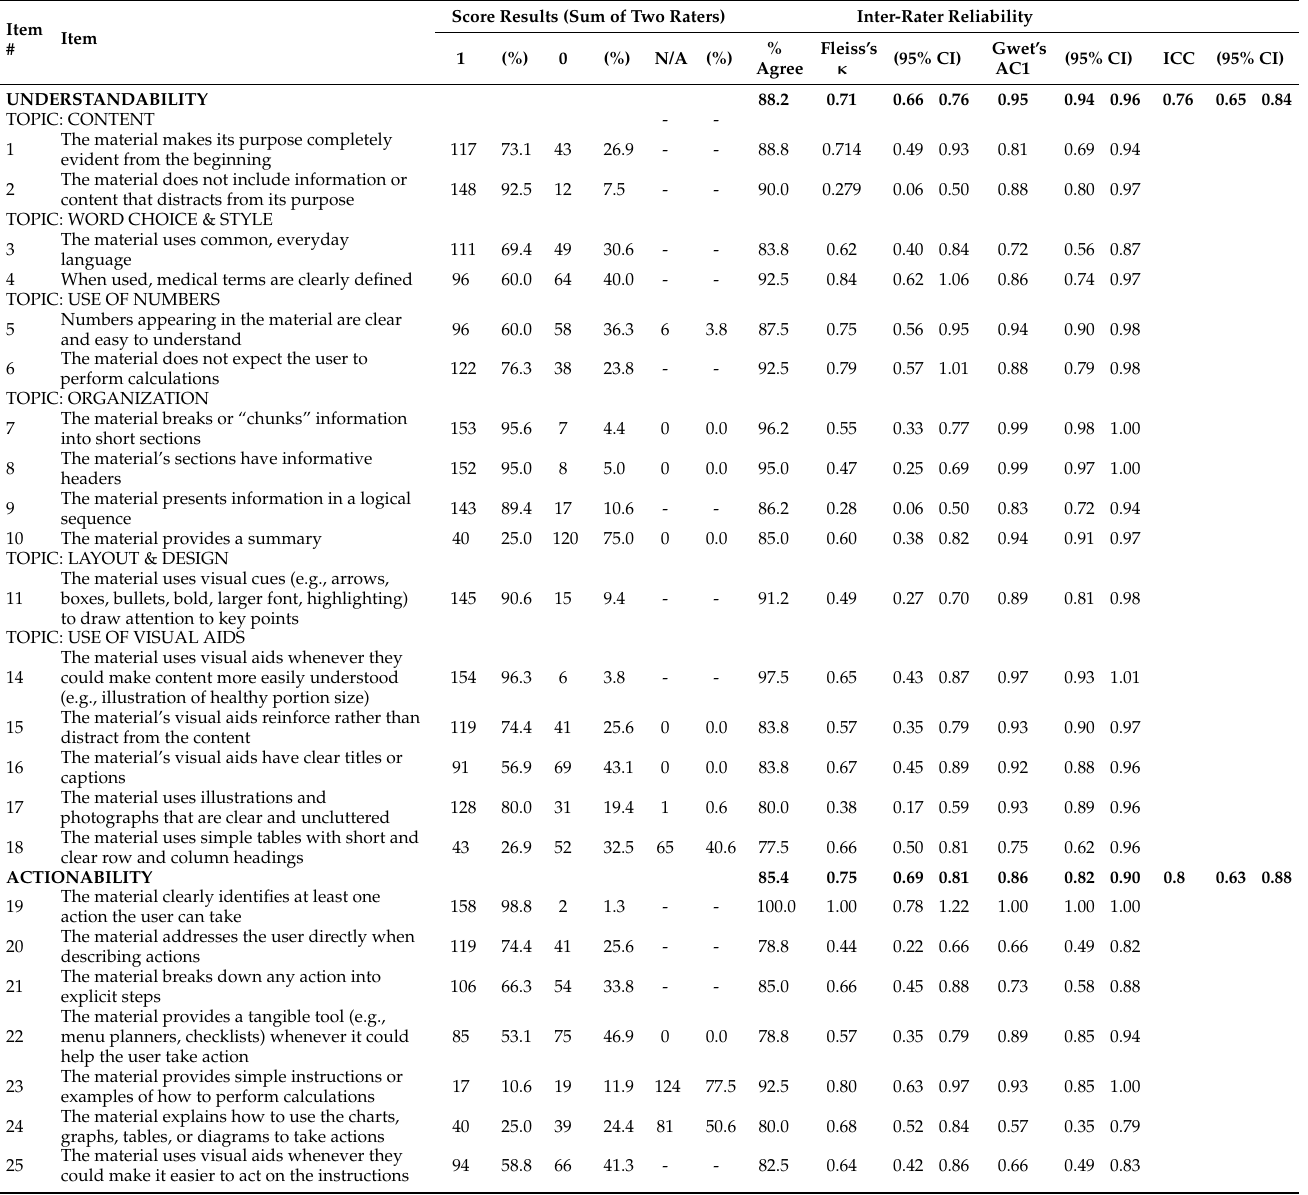
Table 1. Item-level reliability and validity results for items in the Japanese